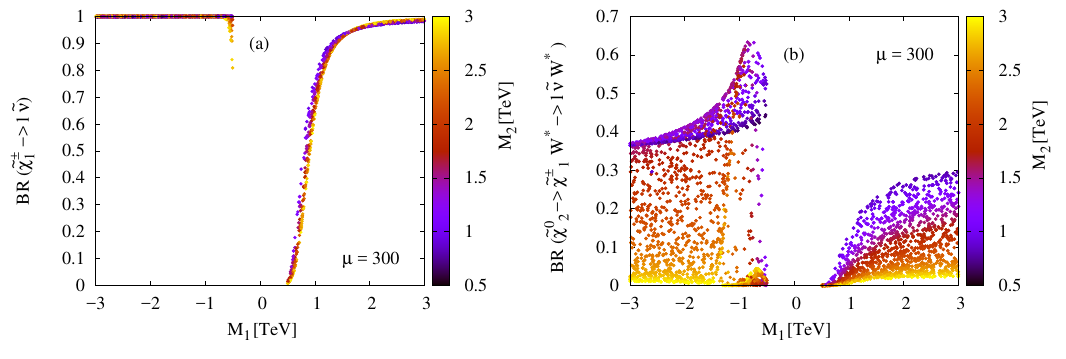
Figure 5 . Variation of the leptonic branching ratios of bino soft mass parameter, M 1 for the Higgsino mass parameter, (cid:22) = 300 GeV. The wino soft mass parameter M 2 is shown in the palette.